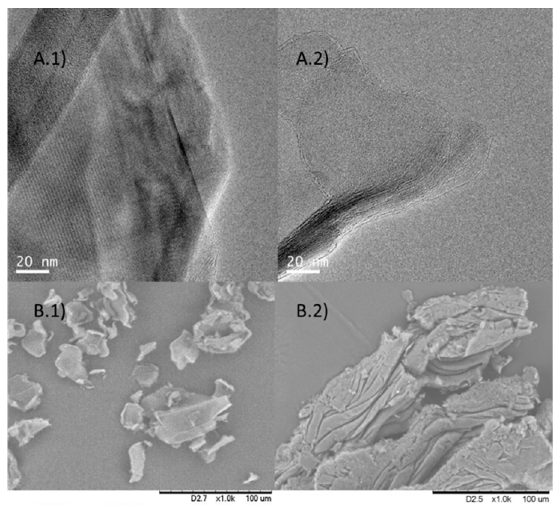
Figure 8. Characterization of biographene-2 . ( A ) TEM images.1) CAL-B, 2) TLL, ( B ) SEM images. 1) CAL-B, 2) TLL.